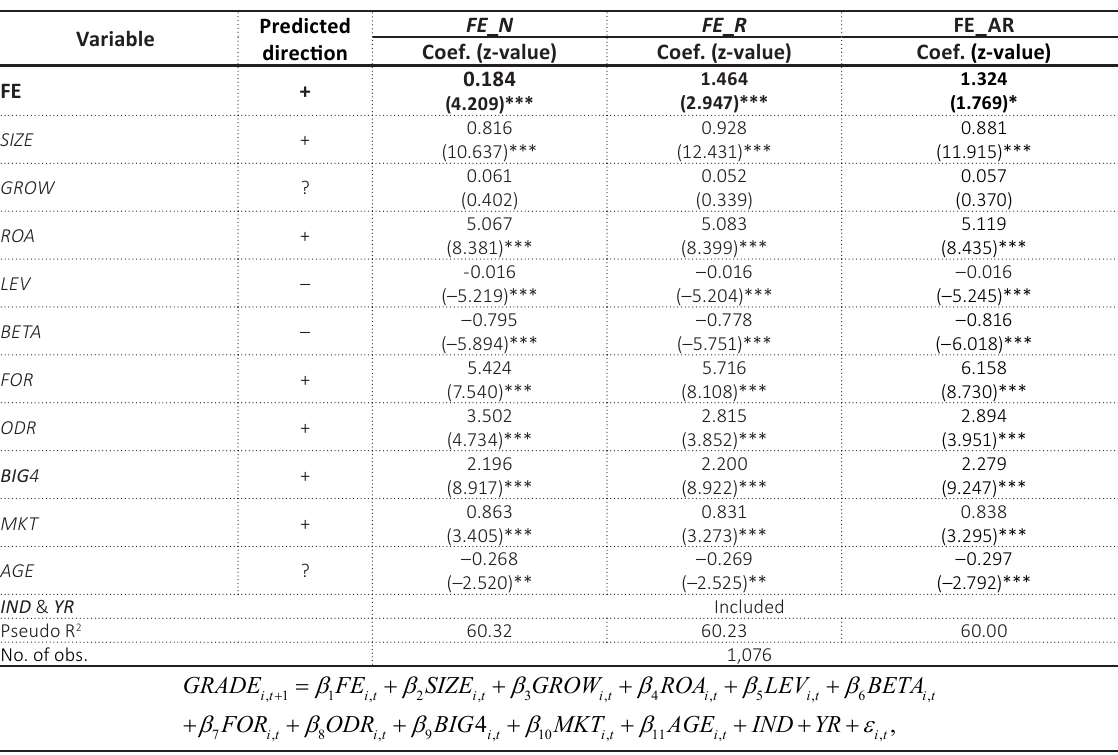
Table 2. Effect of female employees on corporate credit ratings ( H1b